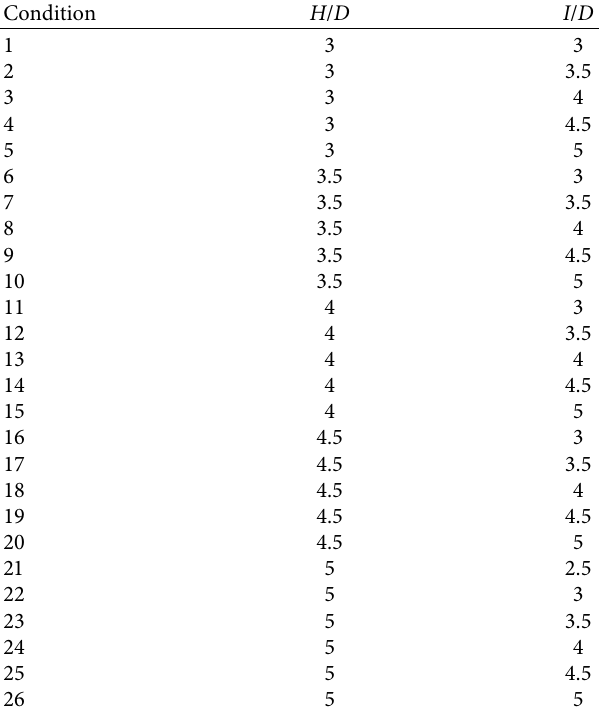
Figure 3: Schematic diagram of the left half of the utility tunnel (unit: Table 1: Model working condition statistics.